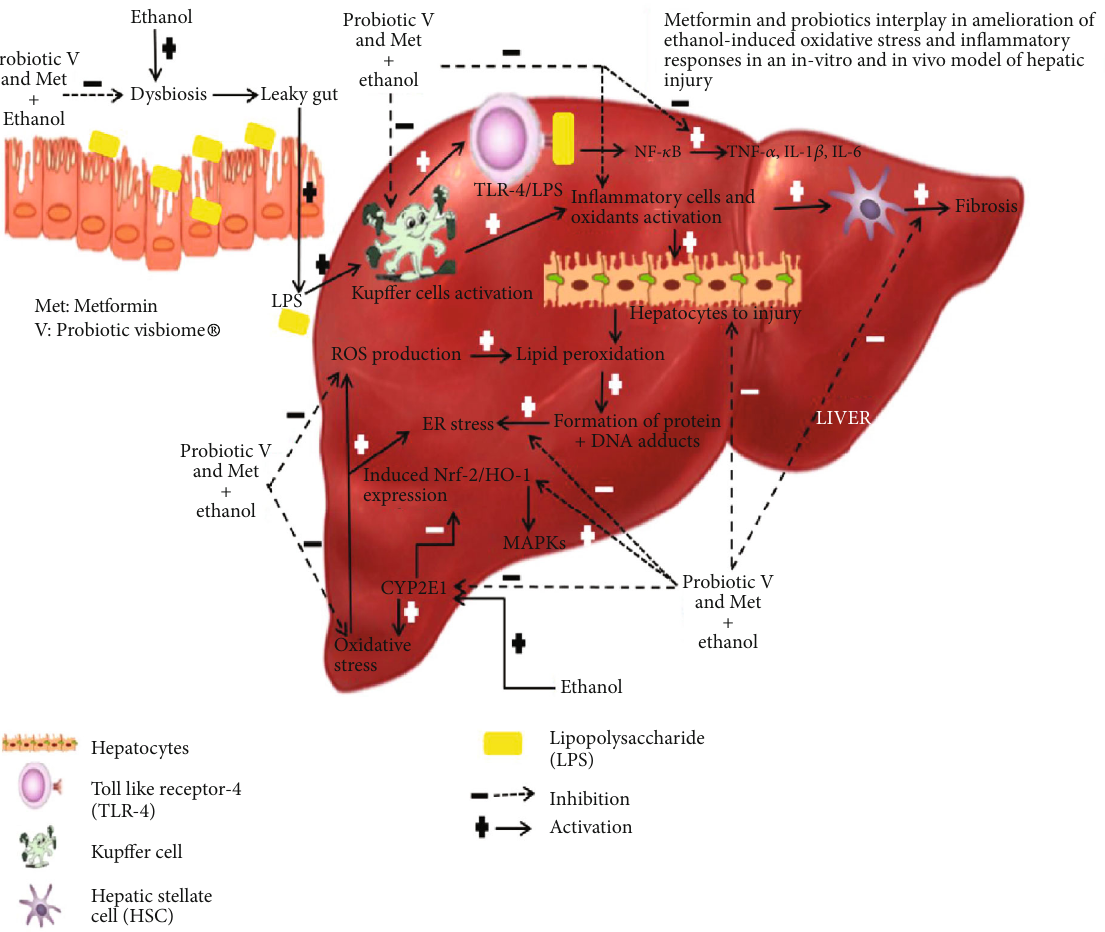
Figure 15: Possible mechanism contributing to the combined protecting e ff ect of probiotic V and Met against ethanol-induced hepatic